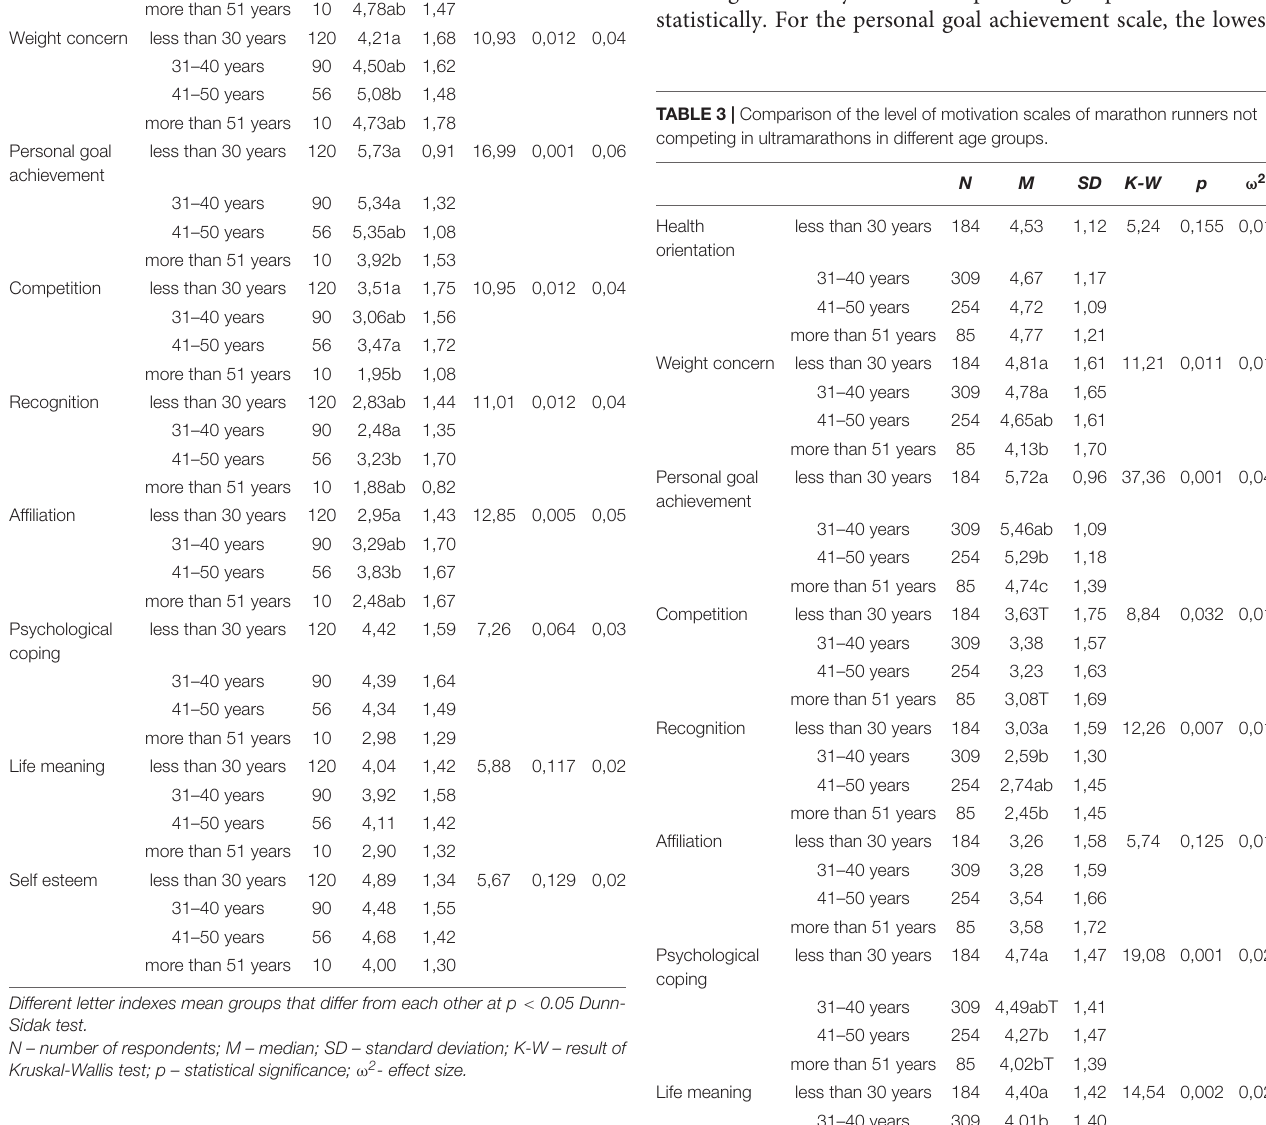
TABLE 2 | Comparison of the level of motivation scales of recreational runners in different age groups. N M SD K-W p ω 2 Table 3 . For the weight concern scale, two statistically significant differences were noted ( p = 0.011). The lowest motivations results were recorded in the oldest age group, i.e., runners over 51 years old. This group differed from the youngest and